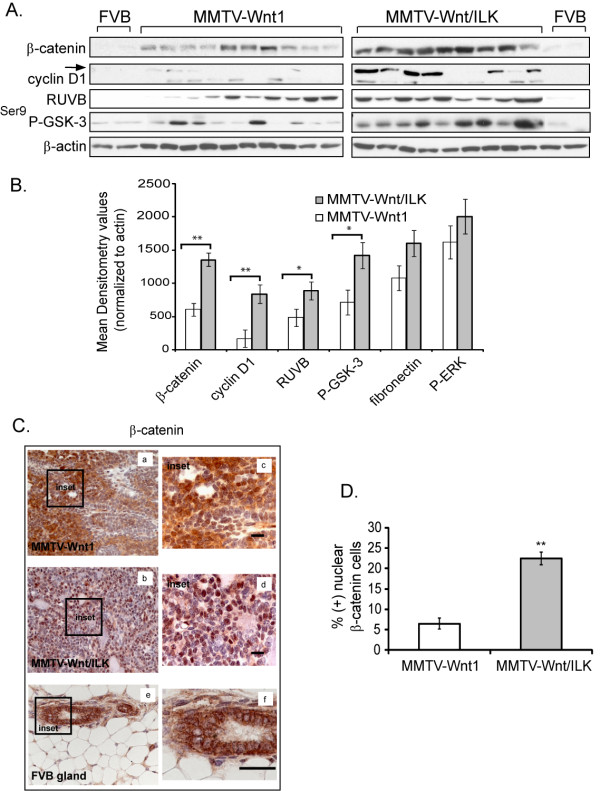
Biochemical analysis, densitometry results, and immunochemistry. (a) The biochemical analysis of the tumors from each group demonstrates upregulation of certain molecular markers in MMTV-Wnt/ILK tumors, which could potentially lead to the more-aggressive growth phenotype observed in these tumors. The lysates from two different FVB mammary glands were used as controls. The blots were generated at the same time, by using the same apparatus, and under identical exposure times and conditions to ensure comparability. (b) The graph for the Western-blot analysis illustrates the densitometry results of the blots. Results represent the mean of densitometry data from 10 independent tumors normalized for β-actin expression. The error bars represent the standard error of the mean (SEM). *P ≤ 0.05; **P < 0.005; calculated by using an ANCOVA analysis. (c) β-catenin immunohistochemistry shows a significant increase in nuclear localization in excised tumors from MMTV-Wnt/ILK mice, suggesting a more-active β-catenin-mediated transcriptional machinery. Magnification: (a,b) 40×; (c,d) 63×; n = 4. β-catenin staining of the normal FVB mammary gland is included as a control (e,f). Scale bars, 25 μm. (d) Positive nuclear β-catenin staining was determined by counting the cells that showed overlapping hematoxylin and β-catenin staining. The cells were counted in five equal randomly chosen fields of view at 40× magnification in four individual tumors. Results are reported as the mean of the ratio of the total number of the nuclear-positive cells to the total cell count. The error bars represent the standard error of the mean (SEM). **P < 1.1 × 10-7 was calculated by using a paired two-sample t test.